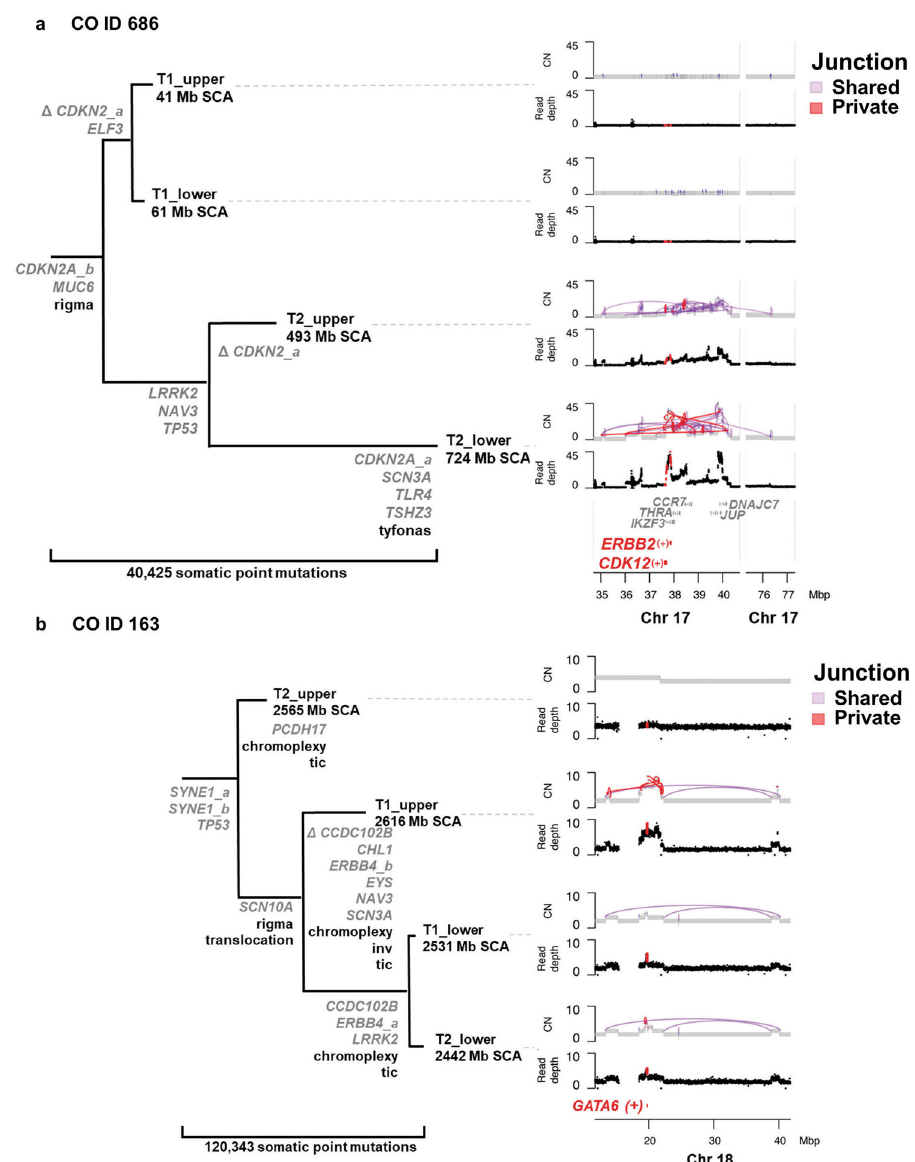
Fig. 4 Gene alterations within complex SV events selected in CO patients. a CO ID 686 with complex SV in both T2 samples, which cluster together in the SNV-based parsimony tree. The phylogeny is annotated with ESAD genes of interest with functional 2 + caller mutations (multiple mutations in the same gene are appended with _a, _b ), and Δ indicates chromosome copy loss of mutated allele. The complex structural rearrangement pattern of rigma 23 was detected in all four samples, whereas tyfonas ( “ typhoons ” of high junction copy number junctions and fold back inversions 23 ) was only detected in the T2 sample, shown in the right panel. Within this region, CDK12 was disrupted by structural alterations and ERBB2 was within one of the highly ampli fi ed regions within this complex SV. b CO ID 163 with expanded TP53 − / − and genome doubling in all four samples. The three samples on the lower clade in the SNV-based phylogeny share a common ampli fi ed region which includes increased copies of GATA6 and surrounding genes. Total Mb SCA are indicated for each sample. CN = copy number. Source data are indicated in Figure Source Data